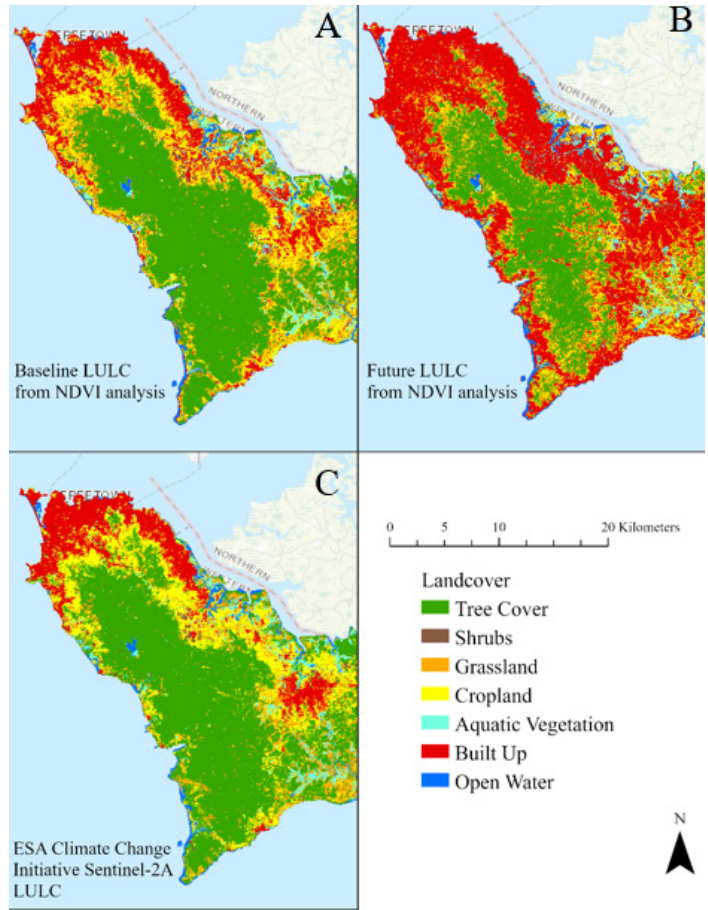
Figure 3. Development of future LULC map. ( A ) Baseline LULC map developed from reclassification of NDVI values. ( B ) Future LULC map developed from projection and reclassification of NDVI values. ( C ) Template baseline LULC map from ESA Climate Change Initiative Sentinel-2A.